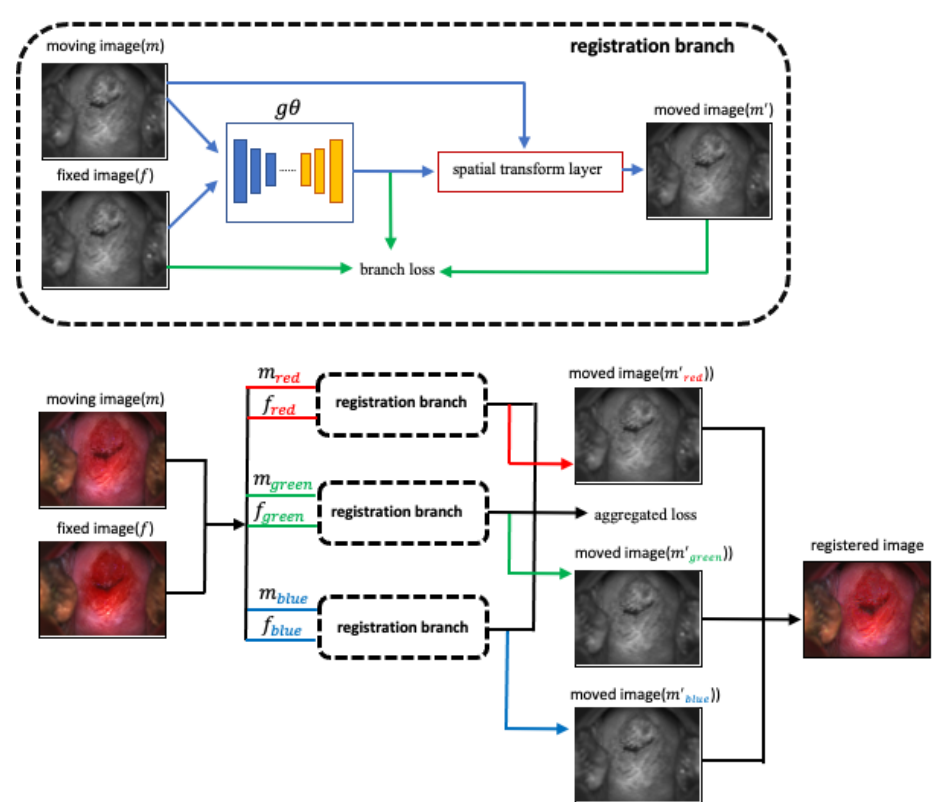
Figure 2. Network structure. To register an RGB color image, we use three branches, each of which takes one of the R, G, and B channels, of an image frame as the input, respectively. The input of each branch consists of two channels, a moving image and a fixed image, that are randomly sampled from the same time sequence. The architectural designs of each branch are the same, and the losses from each branch are aggregated and backpropagated.